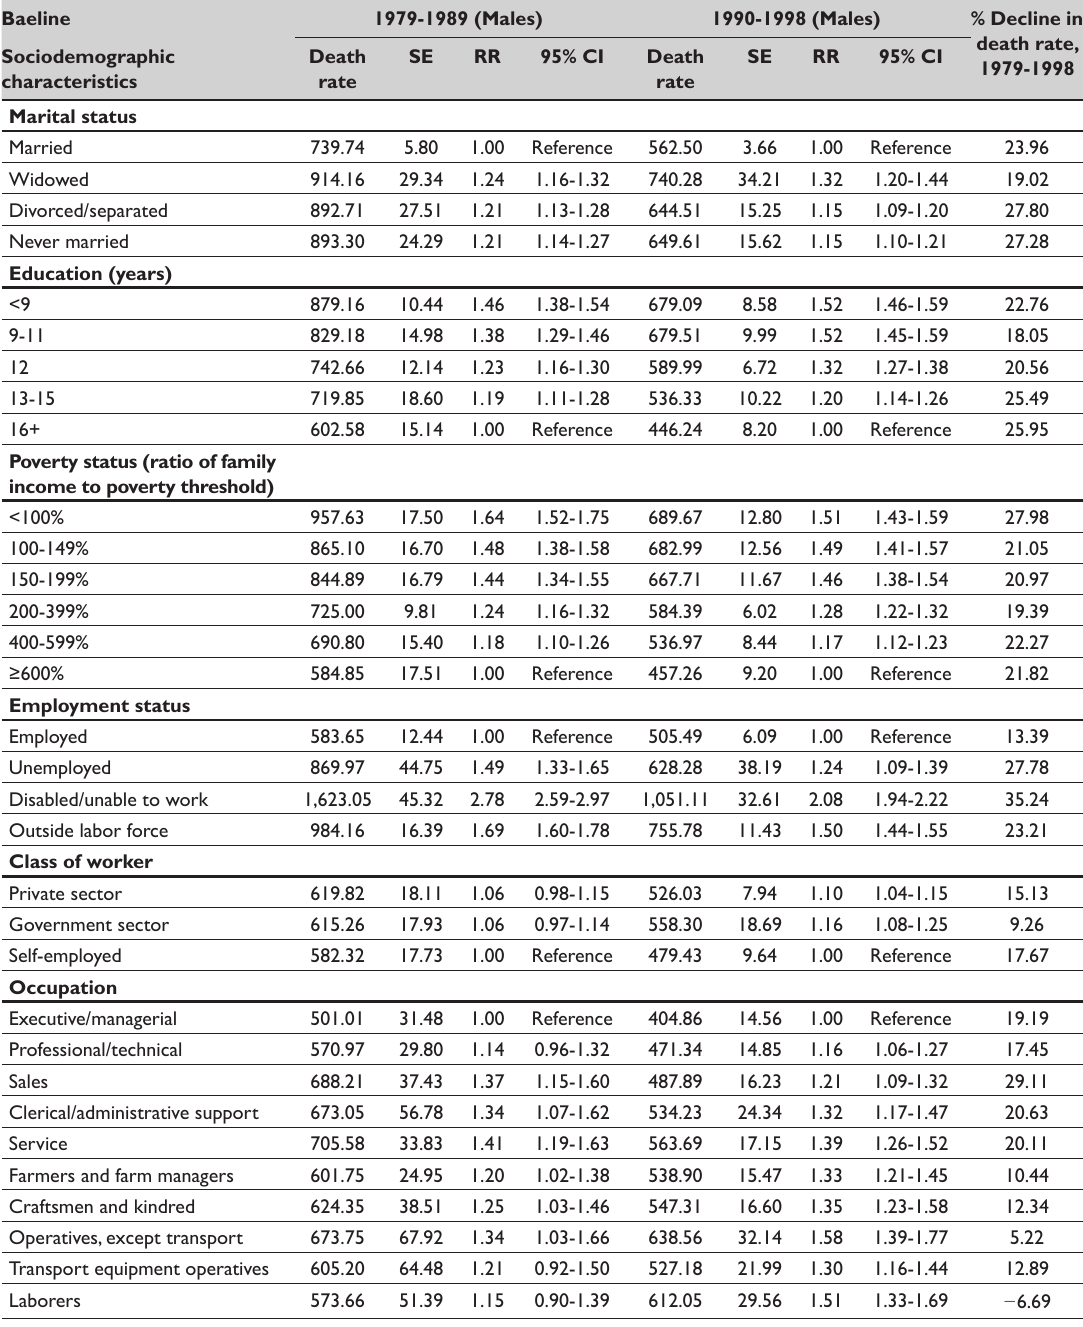
Table 1. Age-Adjusted Death Rates per 100,000 Person-Years of Exposure and Relative Risks of Cardiovascular Disease (CVD) Mortality Among US Males Aged 25+ years: The National Longitudinal Mortaliy Study, 1979-1998